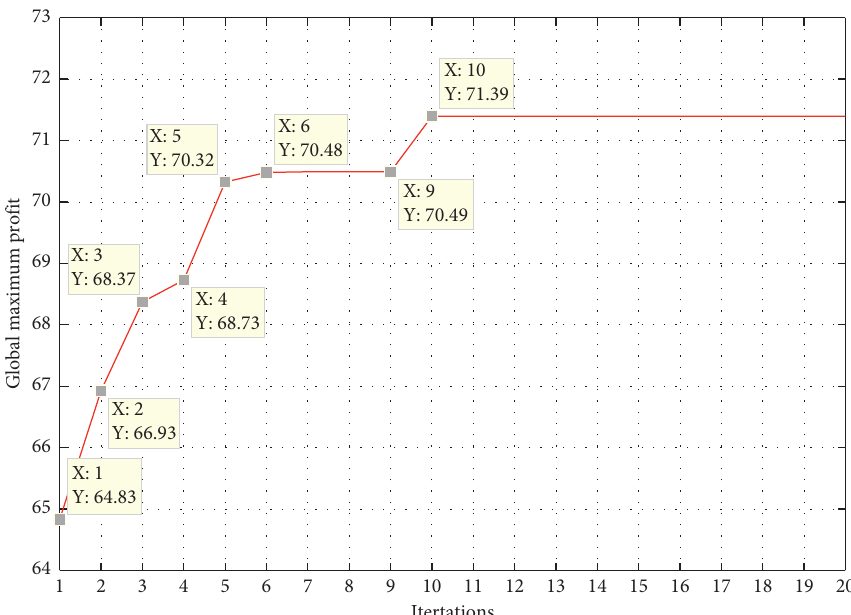
Figure 5: Iteration diagram of global maximum